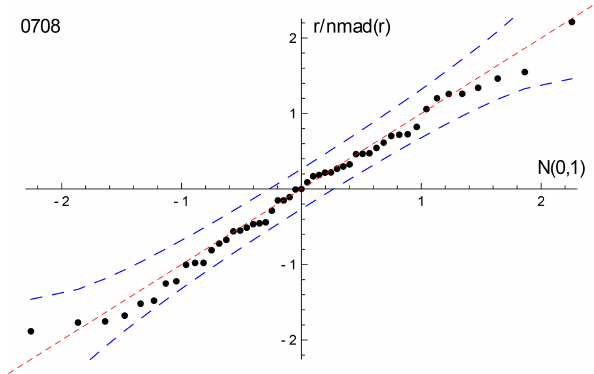
Figure 8. Quantile–quantile plot for sample 0708, using the SIEGEL fit of the data to calculate the residuals to plot. The dashed red line has unit slope through the origin; the dashed blue lines are the 95% pointwise confidence intervals. See